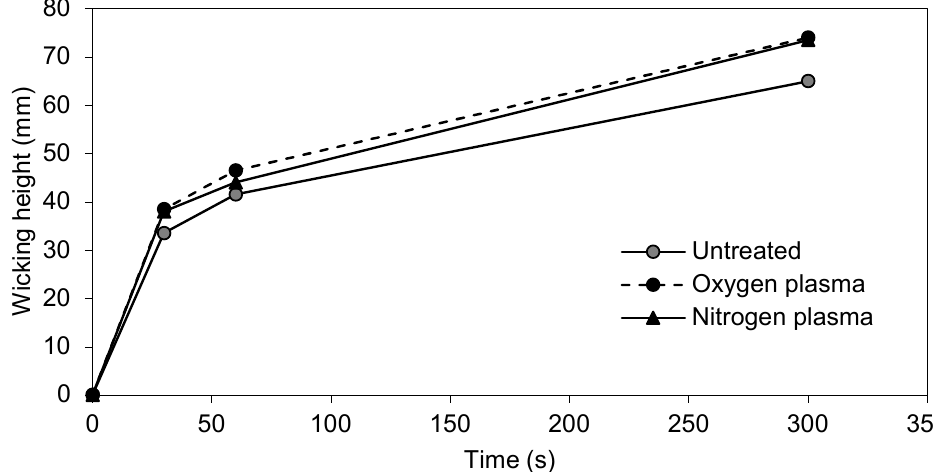
Table 2. Wicking height (mm) of untreated and plasma-treated cotton samples measured after 30, 60, and 300 s.